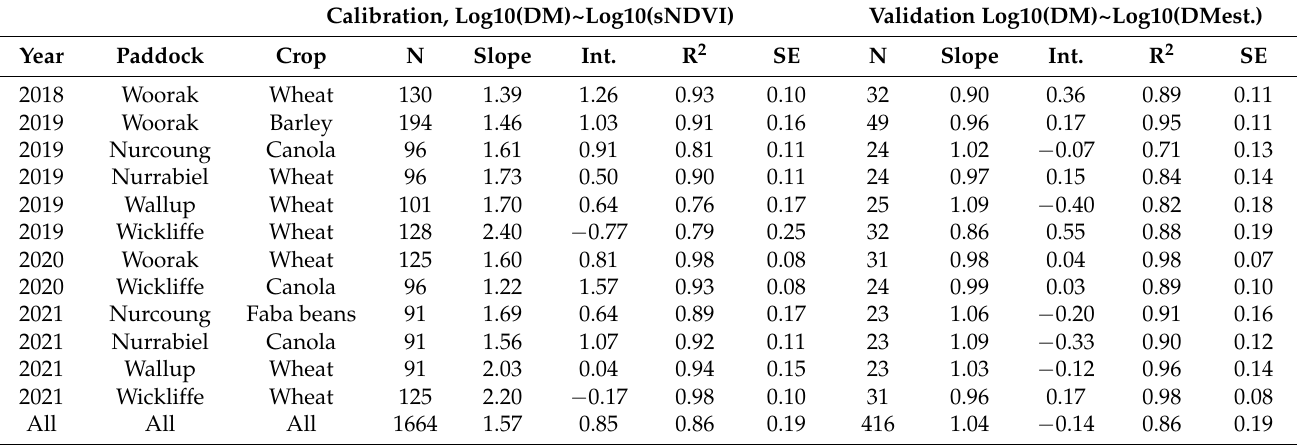
Table 2. Calibration results for the estimated AGB on the sNDVI. The full Training dataset was split into calibration (80%) and validation